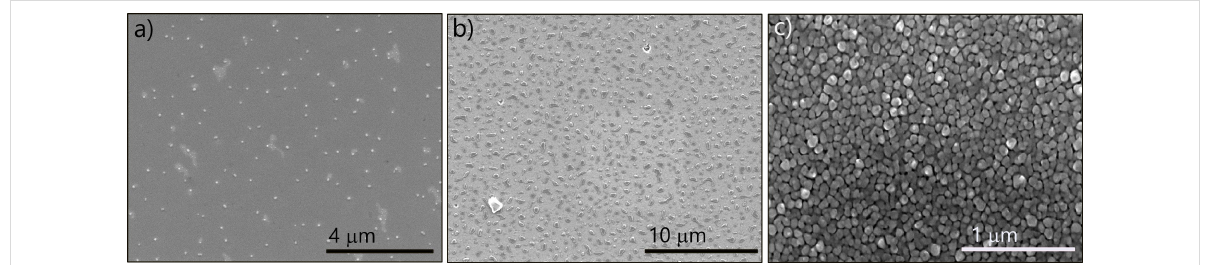
Figure 1: SEM images of the morphological evolution of strained Mn wetting layers with different thickness after annealing at 650 °C for 15 min: (a) 2.2 ML, (b) 6.7 ML, and (c) 9 ML.